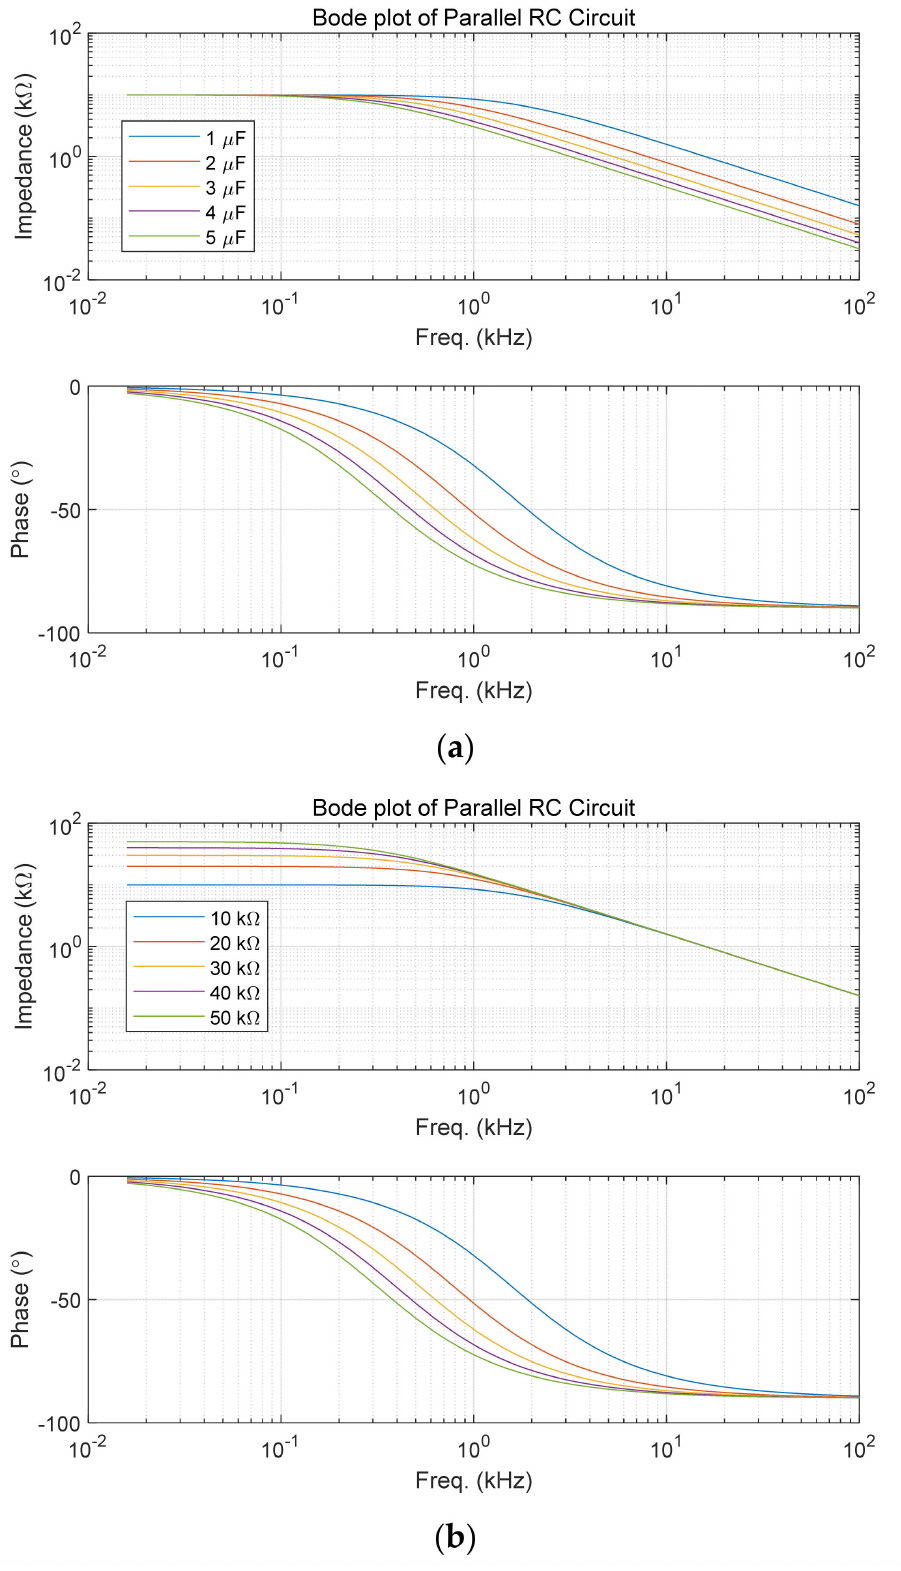
Figure 4. Bode plots of RC parallel circuit: ( a ) Change in capacitance ( R = 10 k Ω ); ( b ) Change in resistance ( C = 1 µ